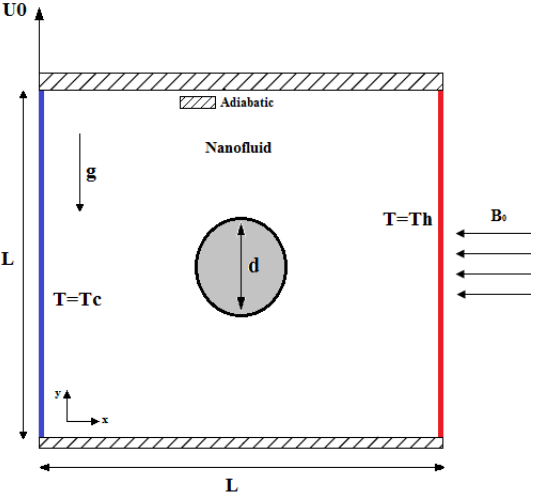
Fig. 1. The geometry of the calculation